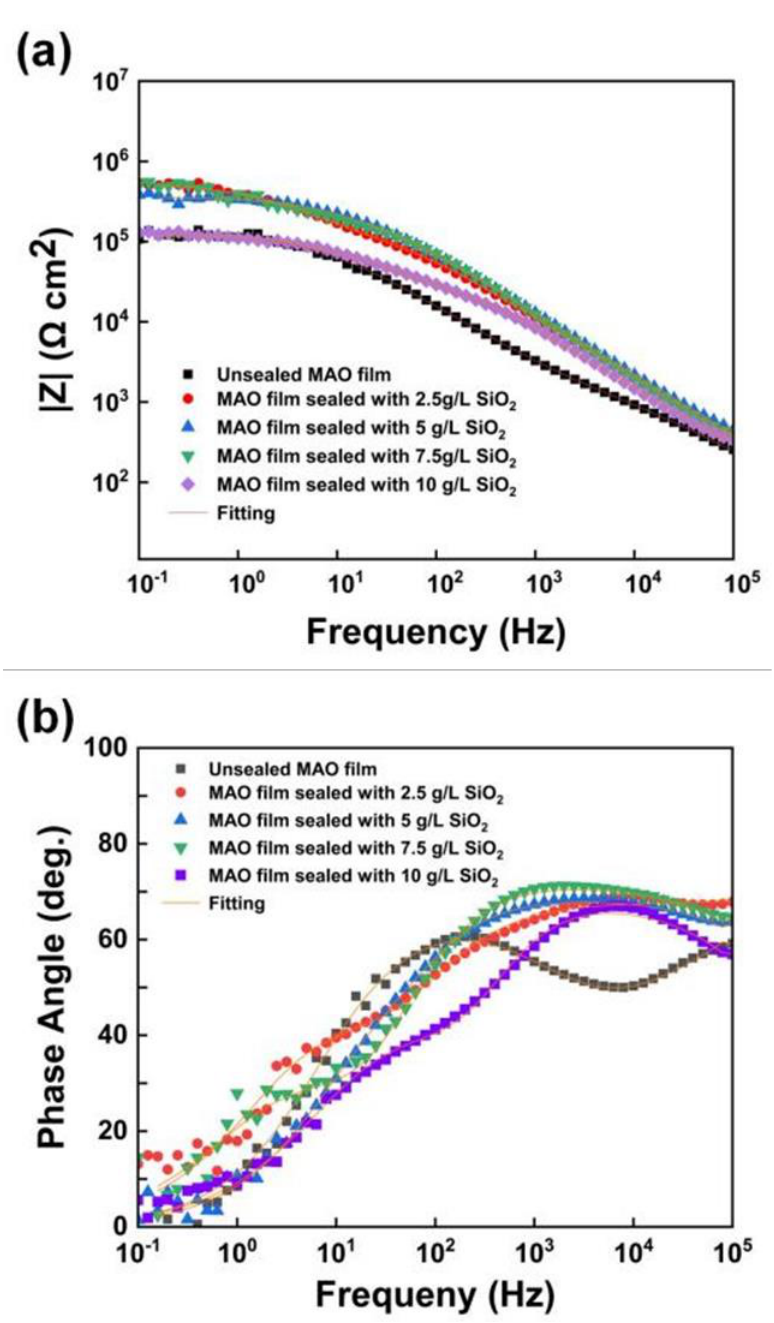
Figure 11. Bode plots of unsealed MAO film and MAO films sealed by SiO 2 nanoparticles: ( a ) rela- tionship between frequency and Z; ( b ) relationship between frequency and phase angle.